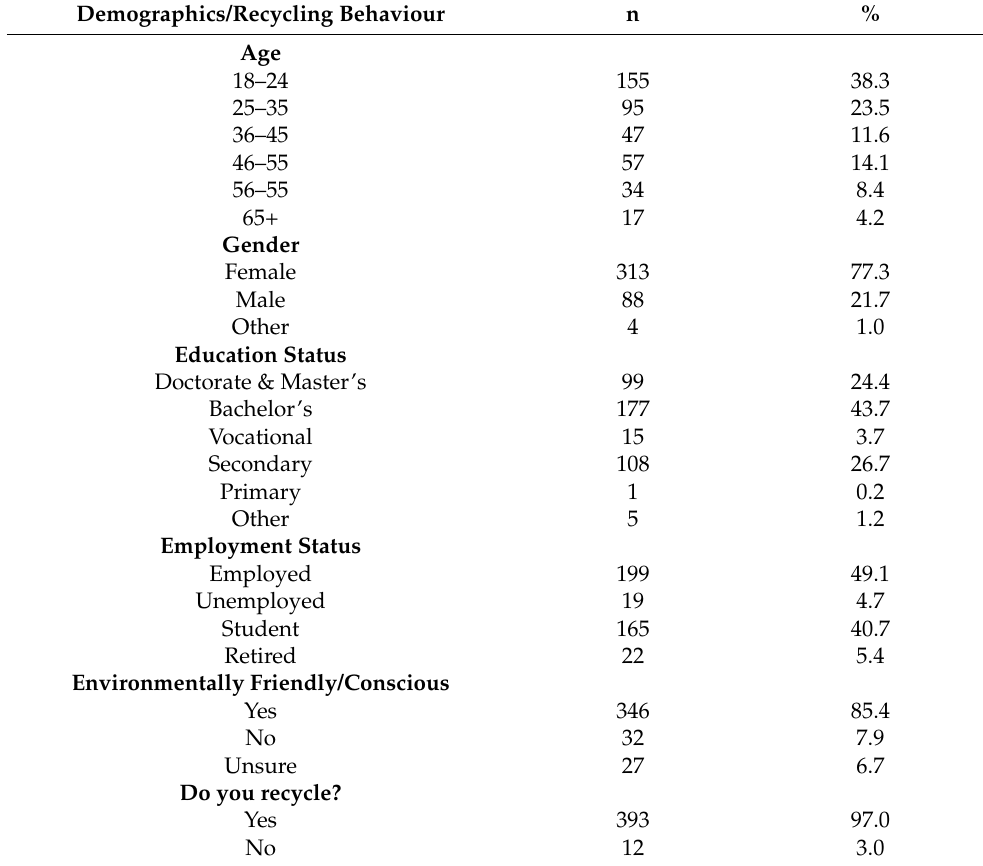
Table 2. Consumers ( n = 405) demographics and recycling behaviour overview (n = number and % =